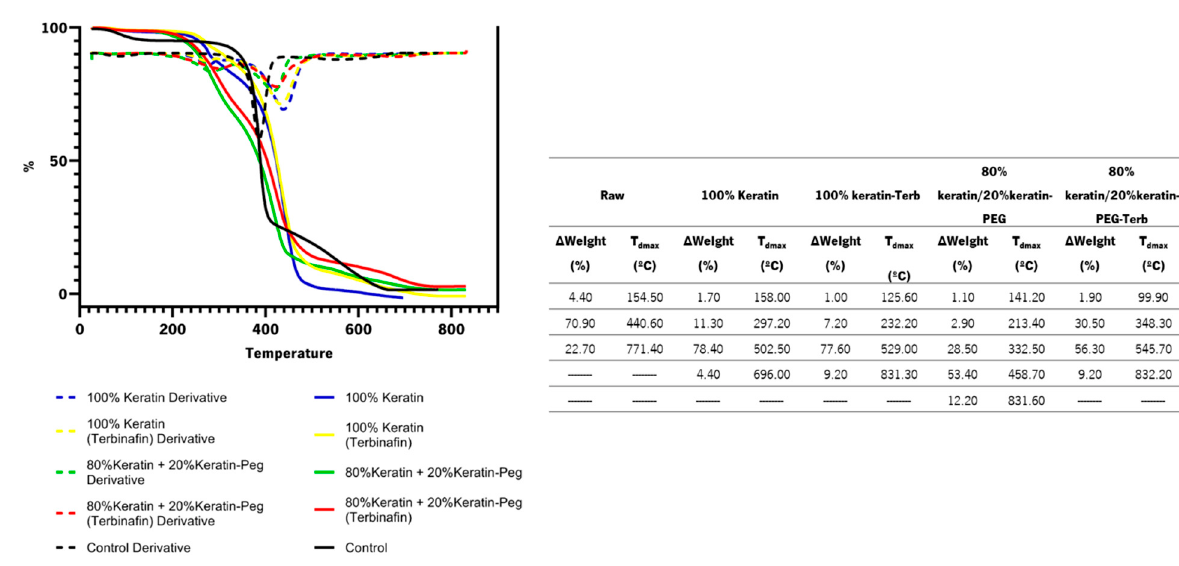
Figure 5. SEM images of cotton fabrics functionalized with keratin particles (100% keratin; 100% keratin-Terb; 80% keratin/20% keratin-PEG; 80% keratin/20% keratin-PEG-Terb) and control sample (raw cotton fabric); images were obtained with an amplification magnitude of 2000×. The arrows highlight the coating with keratin-based particles at the fibers and at the inter-fiber spaces.